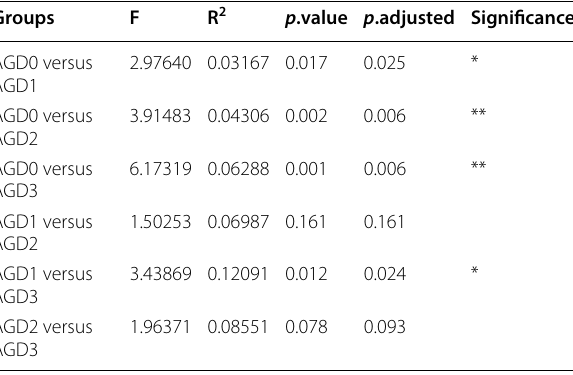
Table 2 Permutational analysis of variance (PERMANOVA) testing pairwise comparisons for pyloric caeca (PC) samples from different AGD severity groups